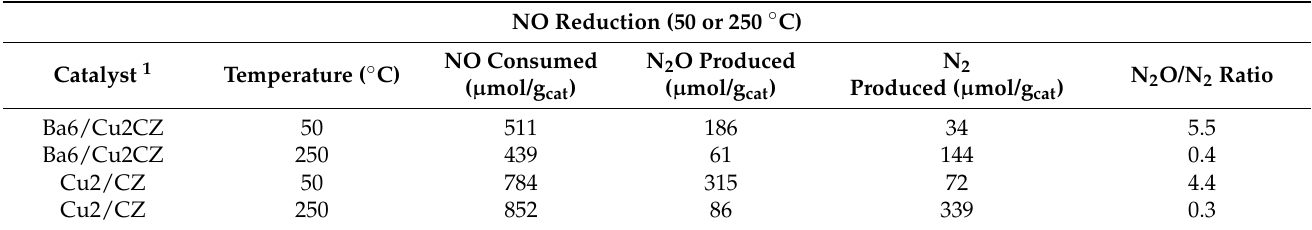
Table 2. Reaction data obtained during NO reduction reaction for pre-reduced Ba6/Cu2CZ and Cu2/CZ . NO Reduction (50 or 250 °C) Catalyst 1